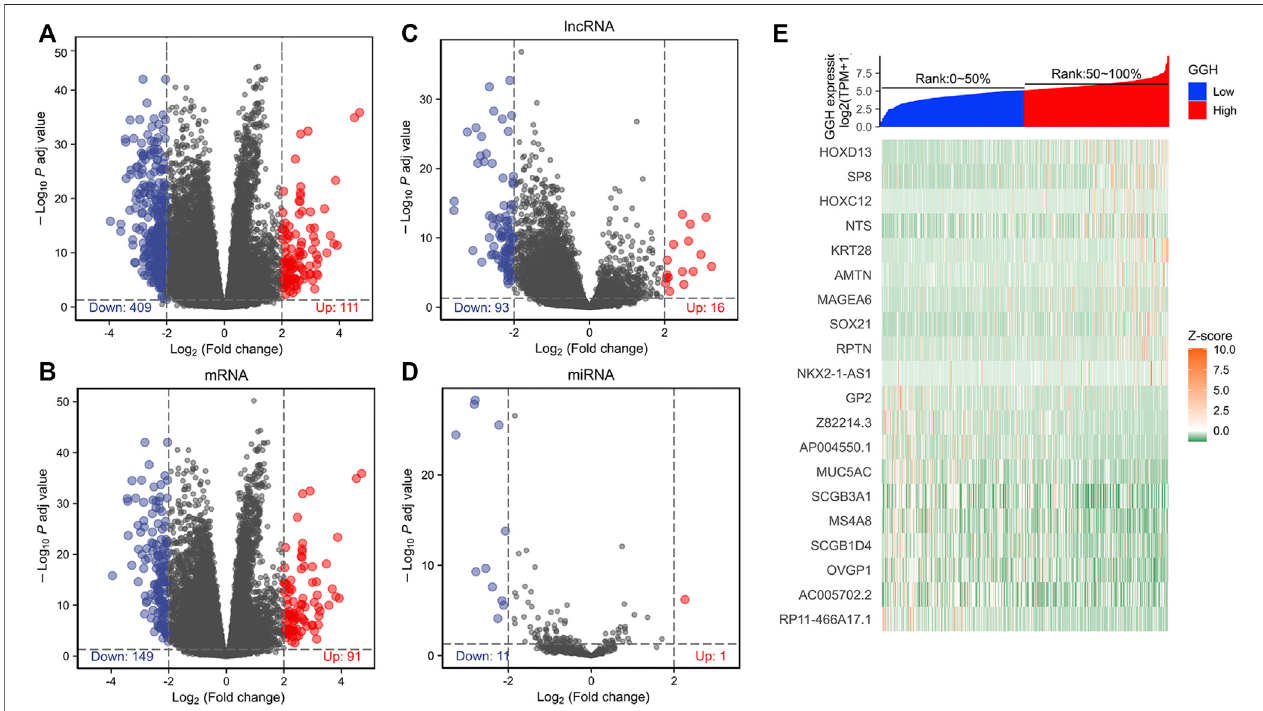
FIGURE 6 | Differentially expressed genes between high and low GGH expression groups from TCGA. (A – D) Volcano plots of total DEGs, mRNAs, miRNAs, and lncRNAs. Red plots indicate upregulated genes, blue plots indicate downregulated genes, and the black plots show those with differential expression below the cutoff criteria. (E) Heatmap of the top 10 upregulated genes and top 10 downregulated genes between high and low GGH expression